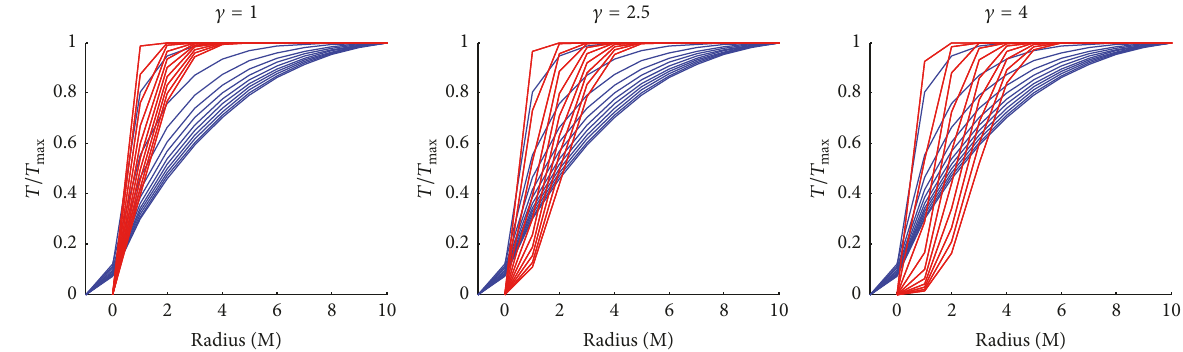
Figure10:MWXfault-controlledcrustalsectionfluidflowheatadvectionspatiotemporaltemperatureprofiles 𝑇(𝑟, 𝑡) forthreevaluesofPeclet number 𝑃 𝑒 = 2 𝛾 = 𝑎 0 𝜑 V 0 /𝐷 . Blue curves are numerical model temperature fields; red curves are analytic temperature fields (16). At the high poroperm sections of the wellbore where fluid flows into the wellbore, the effective Peclet number 𝑃 𝑒 = 2 𝛾 ∼ 5 implies that the effective fault- borne advective heat flow is of order 10 times the ambient crustal sections above and below the fault intersections. The numerical temperature field deviates from the analytic temperature field at larger radii because the fault-borne fluid radial inflow from the localized fault intersections along the wellbore expands axially along the wellbore where the analytic expression assumes no axial flow along the